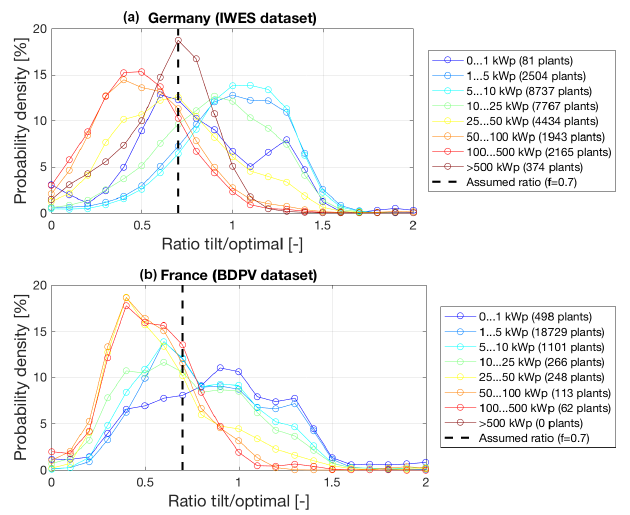
Figure 8. Histograms of the ratio of actual plant tilt angles with the corresponding optimal value for different classes of nominal capac- ity (coloured lines). In the upper plot, the German case is calculated with the IWES database. The French case is displayed in the lower plot where data from BDPV are